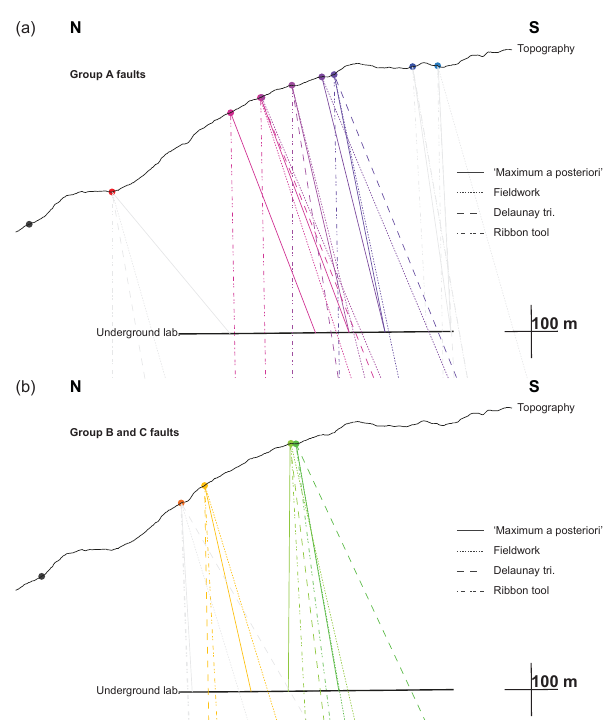
Figure 13. Comparison of maximum a posteriori interpolation with three extrapolation approaches used to assign dip to fault exposure line. Figure subdivided into (a) group A (NE–SW), (b) group B (E– W), and group C (NW–SE). Group B and group C are displayed jointly as group B, which contains only two